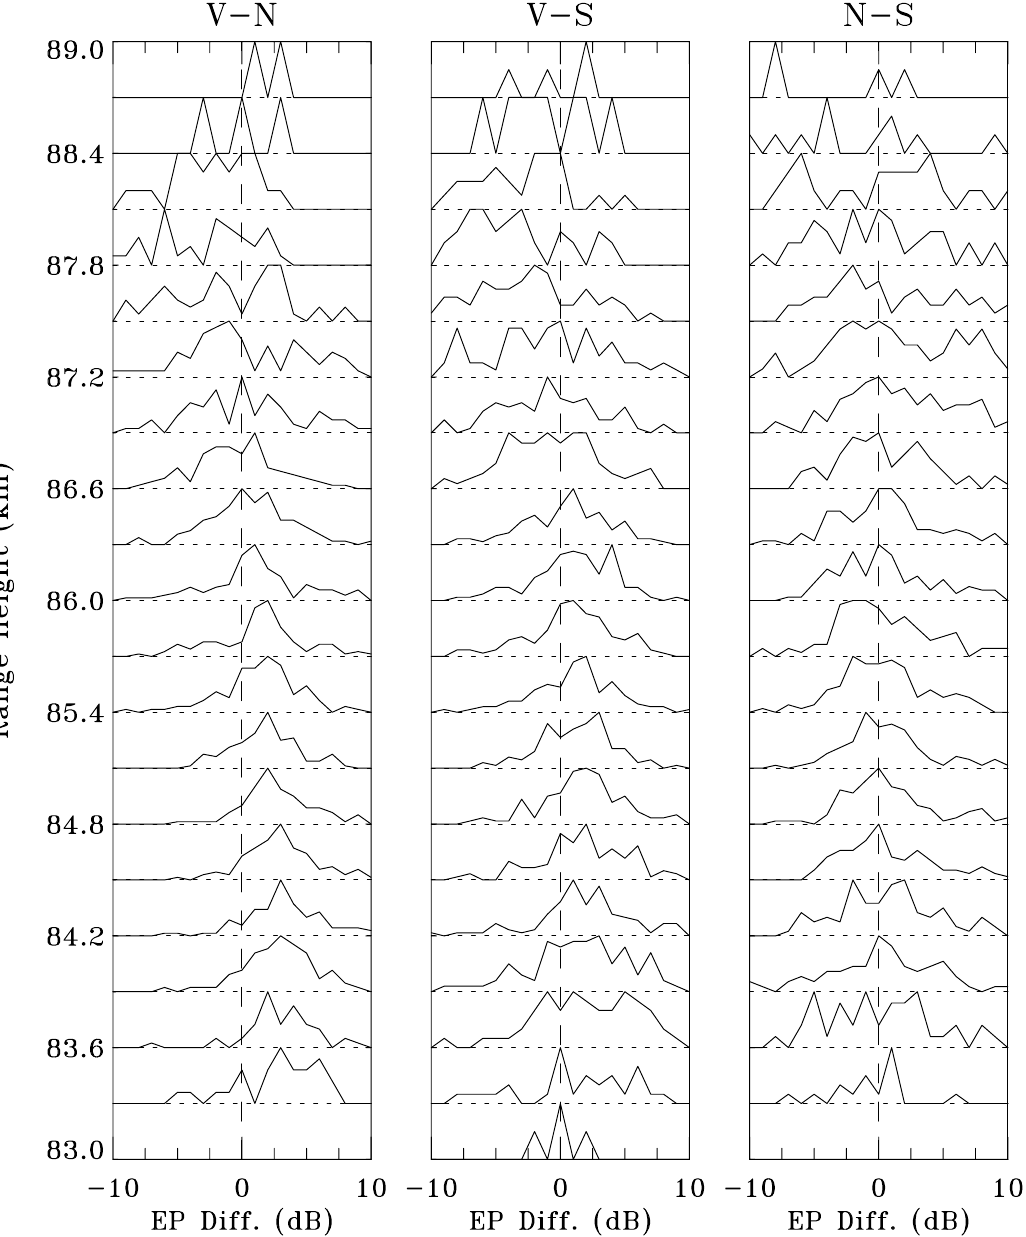
Fig. 7. Histograms of echo power differences between the vertical and northern beams (left panel), the vertical and southern beams (middle panel), and the northern and southern beams (right panel), respectively, for the data set shown in Fig.